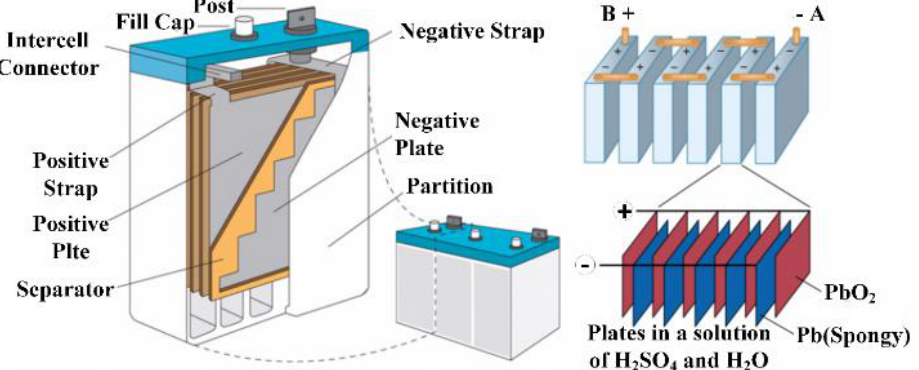
Figure 24. Anatomy of a flooded or wet lead acid cell; the sulfuric acid electrolyte is free to move inside the battery, lead plates act as the electrolyte [80].